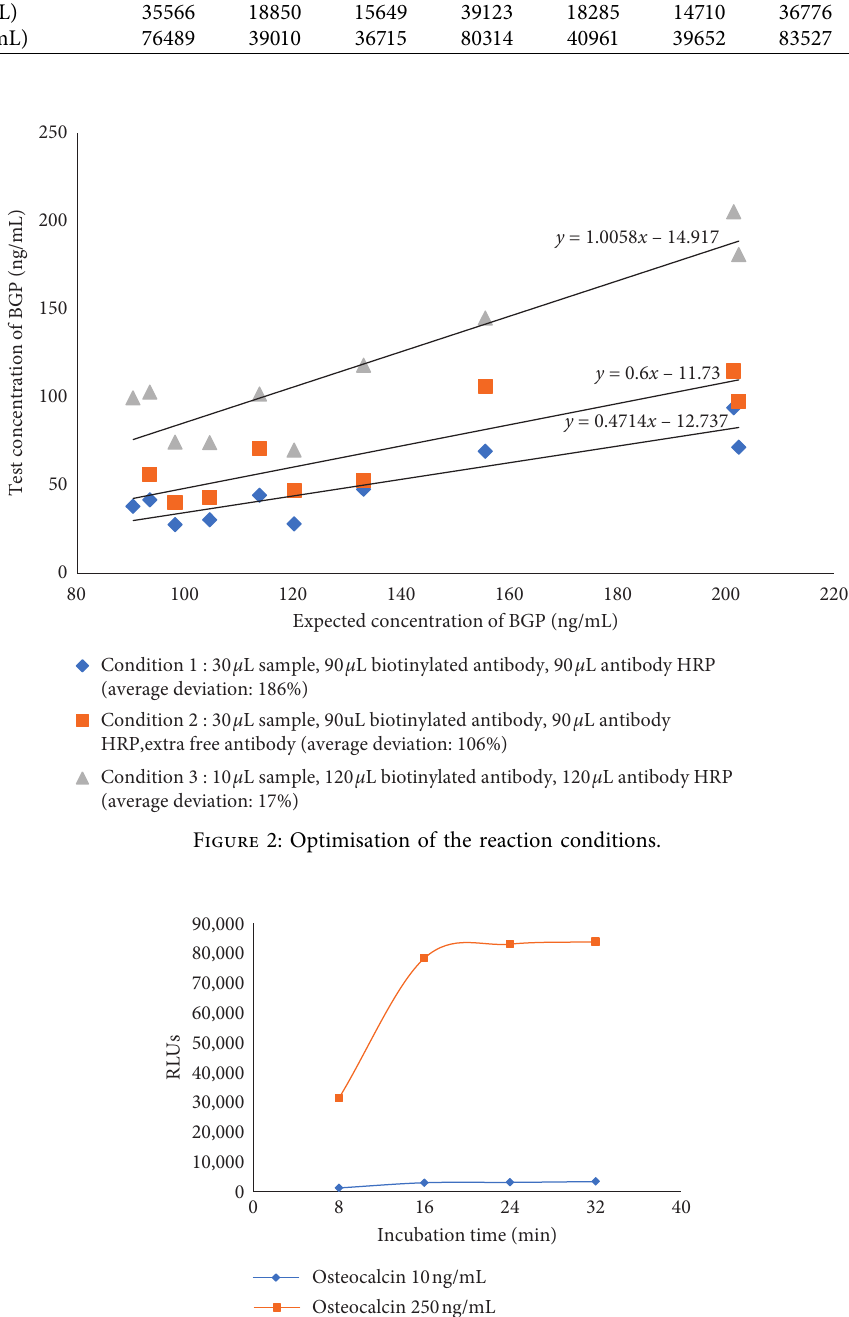
Figure 3: Optimisation of incubation